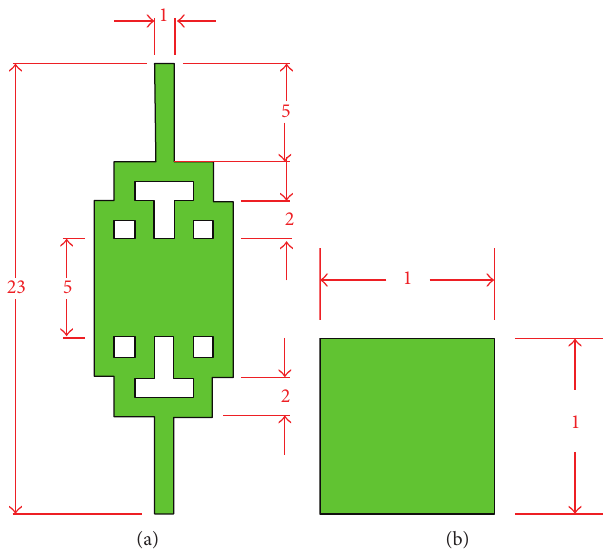
Figure 3: Schematic of (a) the proposed microfluidic channel architecture with (b) its channel’s cross-sectional